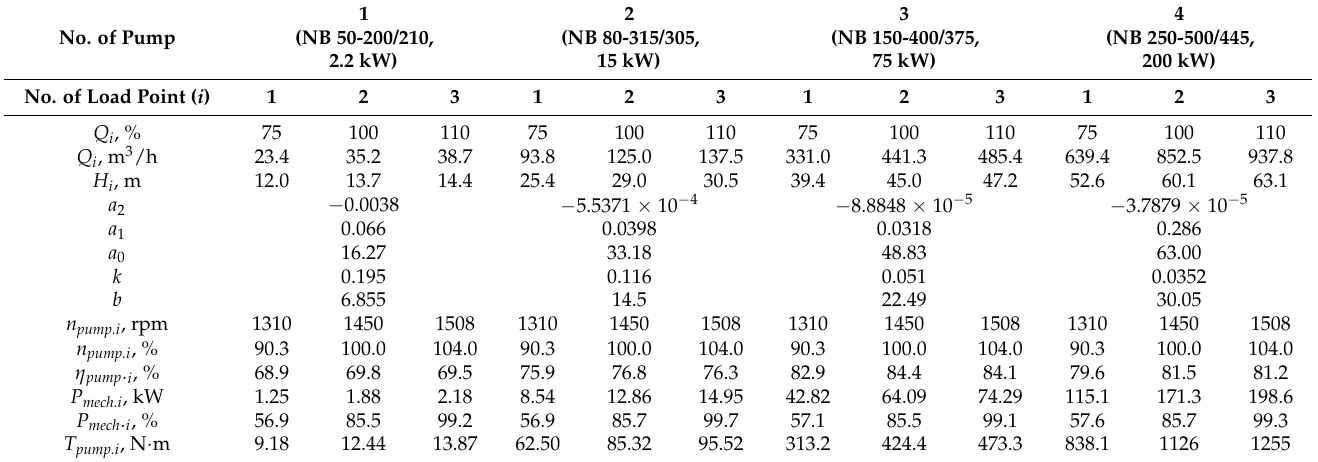
Table 5. Interpolated efficiencies of selected power drive systems.